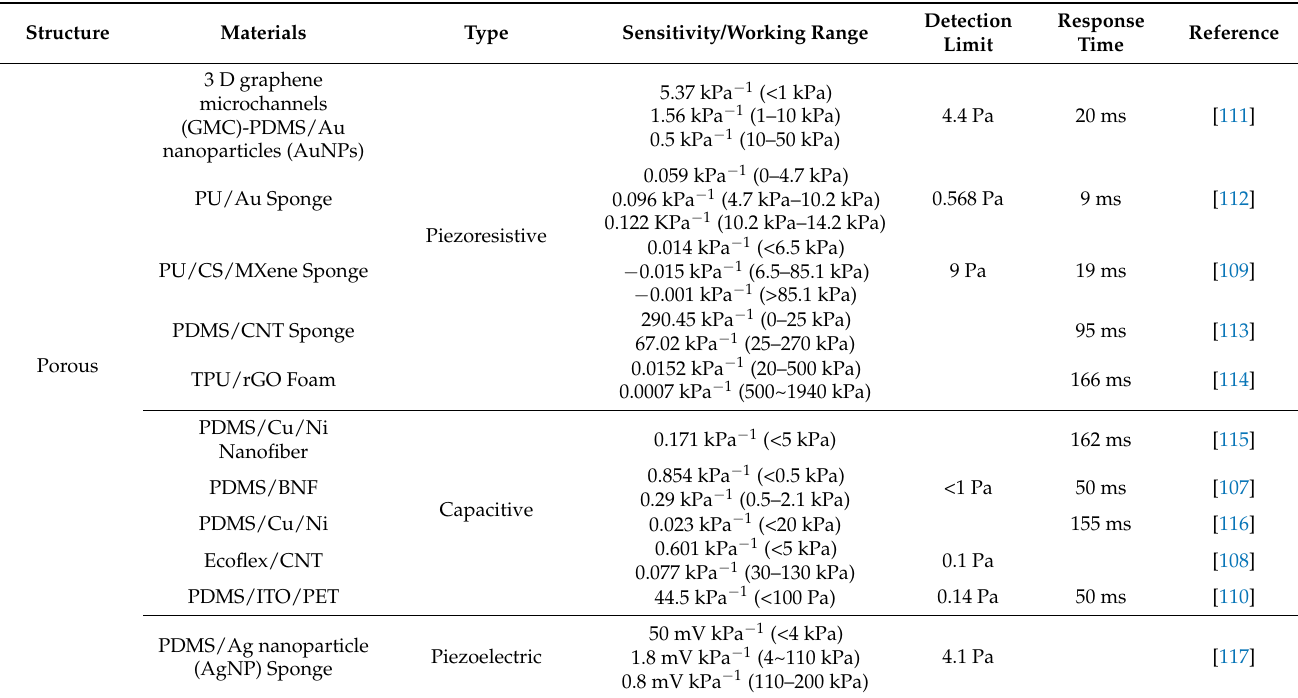
Table 7. The summary of sensor performances with porous